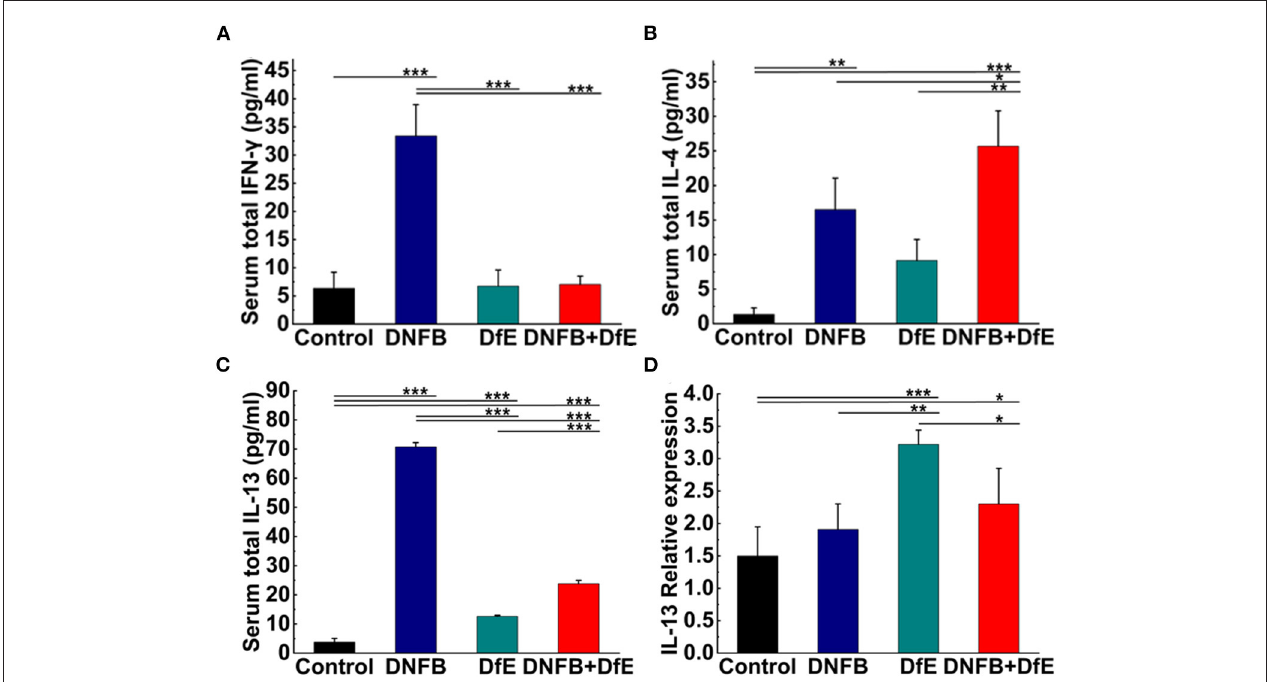
FIGURE 4 | High levels of Th2-related cytokines were triggered by alternate application of DNFB and DfE not only in serum but also in lesional skin. Serum proteins of Th1-related cytokines. (A) interferon (IFN)- γ and Th2-related cytokines; (B) interleukin (IL)-4; and (C) IL-13. High levels of IL-2 appeared only in the DNFB group, but undetectable in other groups (data not shown). Results are representative of three mice in each group ( n = 4 mice). Real-time PCR analysis of (D) IL-13 in mouse lesional skin. The expression of IL-13 mRNA is representative of four mice in each group ( n = 4 mice). The expression of IL-4, IFN- γ , and IL-2 mRNA did not increase in the lesional skin of each group (data not show). Data are shown as mean ± SD. * p < 0.05, ** p < 0.01, and *** p <